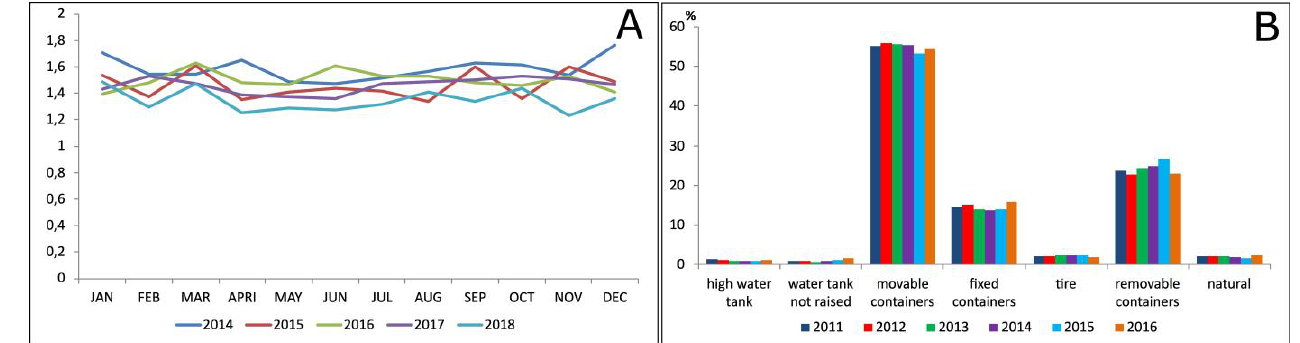
Figure 8 . ( A ) Average of recipients with water/property per month by year; ( B ) Percentage distribu- tion of water breeding sites by type and year. State of São Paulo, Brazil.